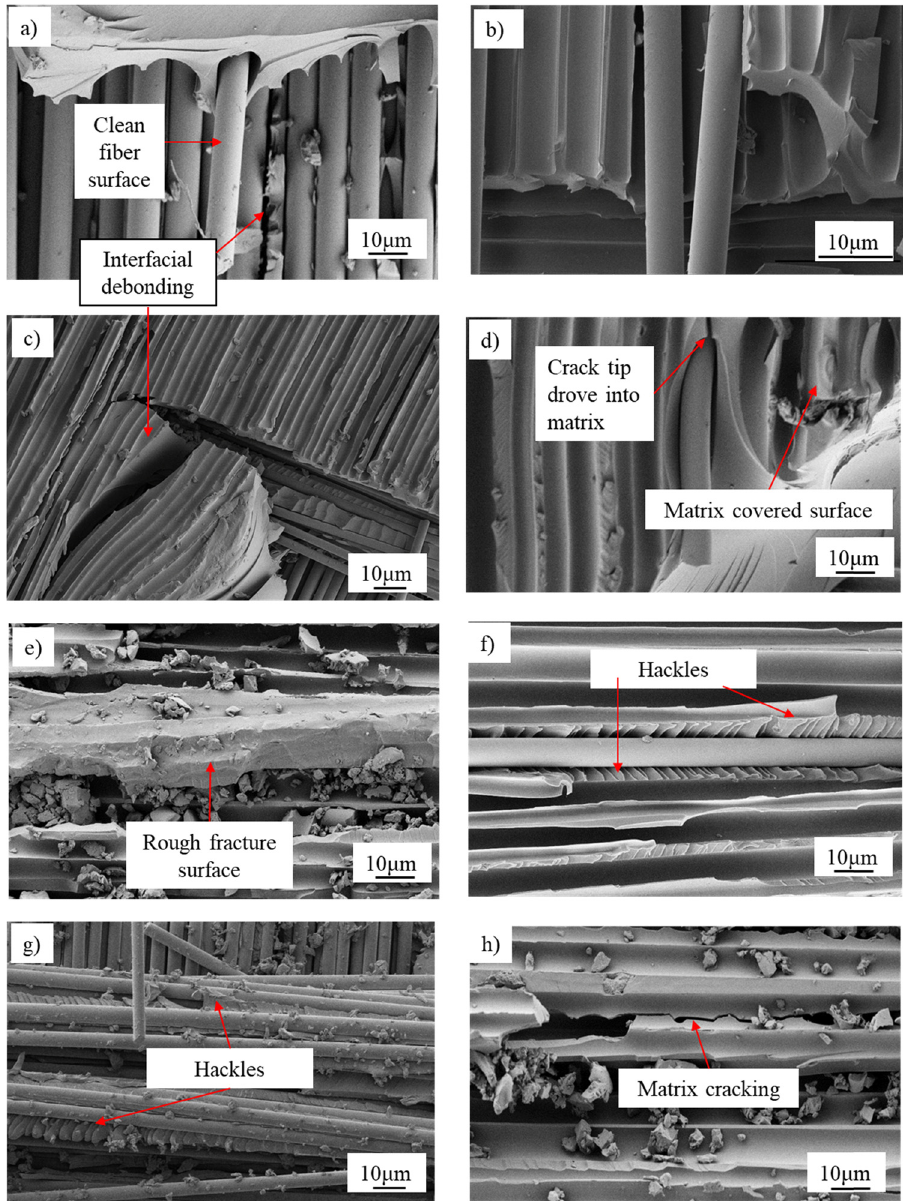
Figure 12: FESEM image of mode I fracture surface of the ( a – c ) control sample ( GF - Epoxy ) ; ( d – h ) hybrid sample ( CNTs - GF - Epoxy )